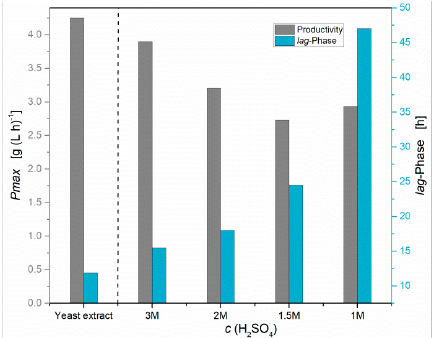
Figure 1. Lactic acid concentrations and maximal productivities of S. inulinus obtained with mildly hydrolysed agricultural residues as nutrient sources in GY-medium compared to the reference with yeast extract, incubated at 38 °C, 0 rpm.